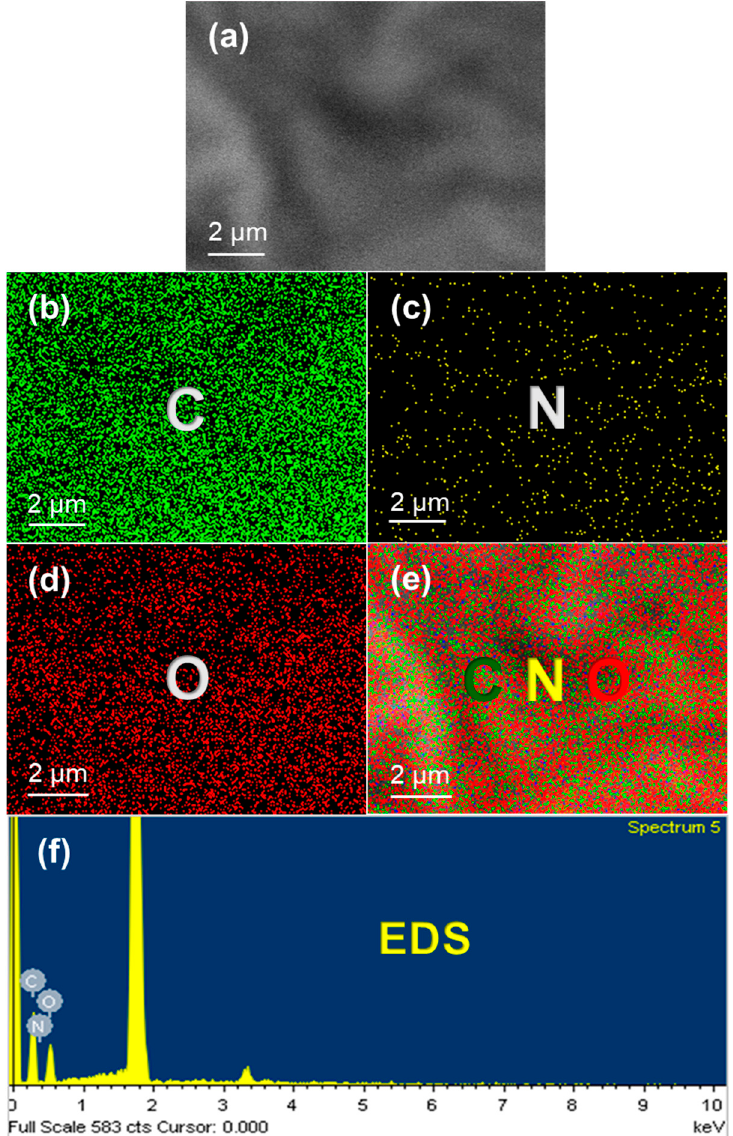
Figure 1. ( a ) FESEM image (mapping area), and the corresponding carbon ( b ), nitrogen ( c ), oxygen ( d ), and overlap ( e ) elemental mapping of synthesized hydrophilic O ‐ CDs. ( f ) The EDS graph of synthesized hydrophilic O ‐ CDs.